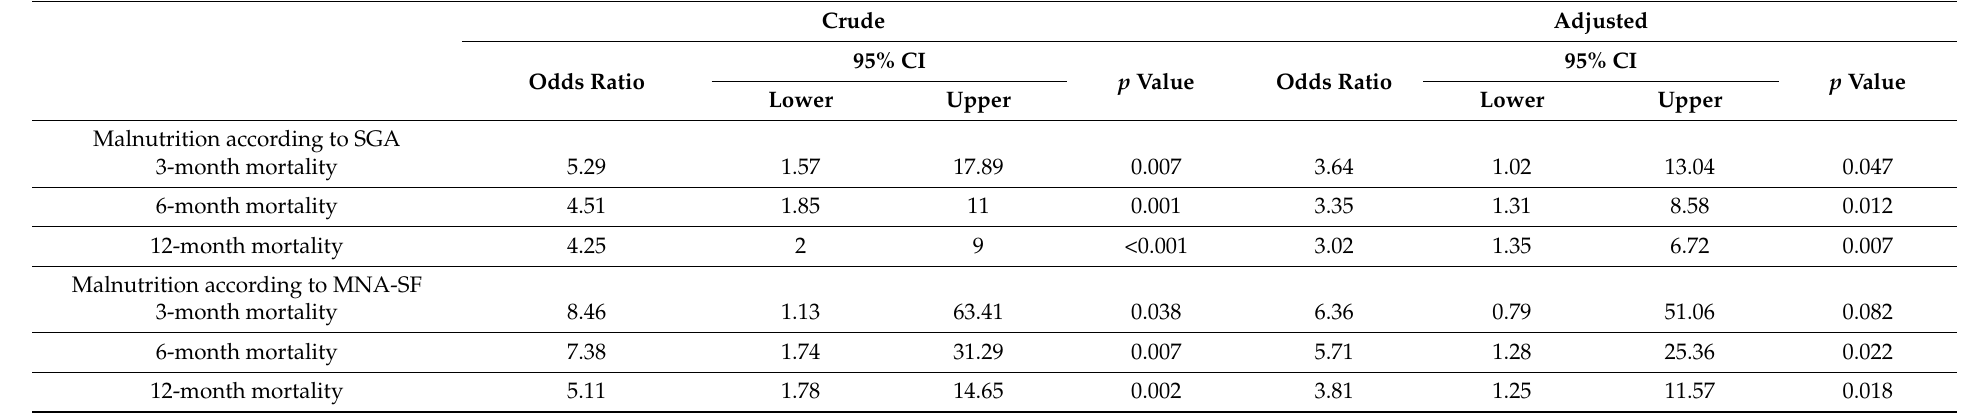
Table 4. Relationship between mortality and malnutrition according to SGA and MNA SF, adjusted for age, sex and Charlson Comorbidity Index.